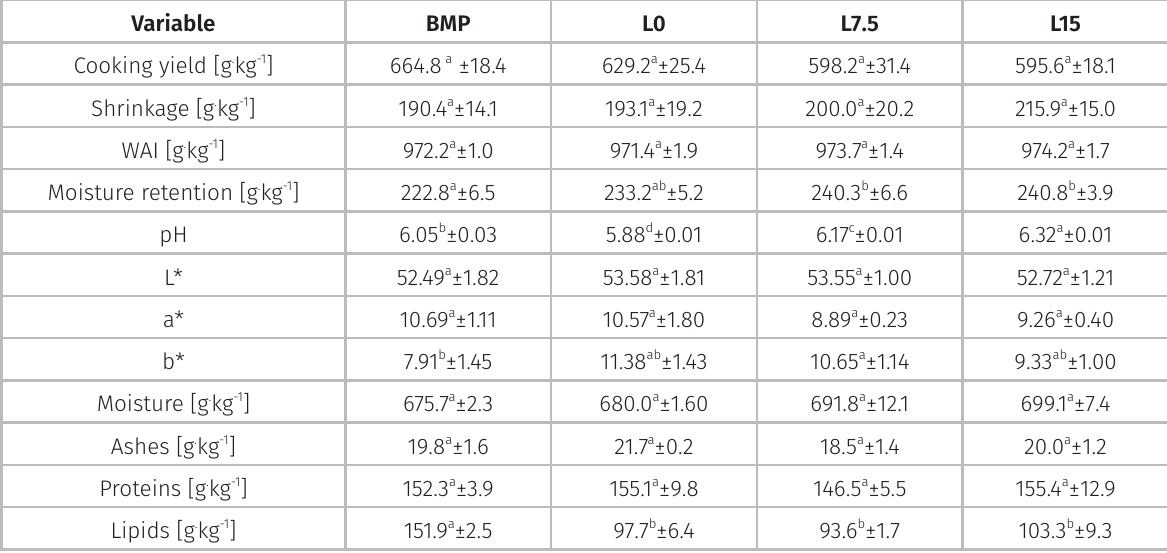
Table IV. Cooking properties, pH, color parameters and composition of meat patty